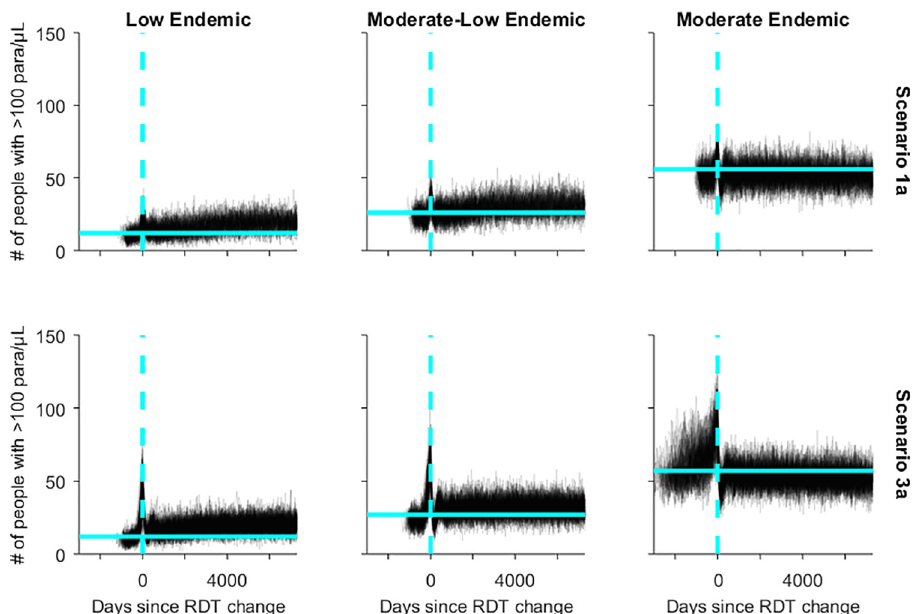
Fig 5. Simulation trajectories for prevalence of asexual infections ( > 100 parasites/ μ L) in a village where 50% of symptomatic patients seek diagnosis and treatment and a Pf-LDH RDT is used after the RDT change. Vertical dashed line: RDT change day; light blue horizontal: 75 th percentile of prevalence in 500 days before introduction of HRP2-negative parasite.